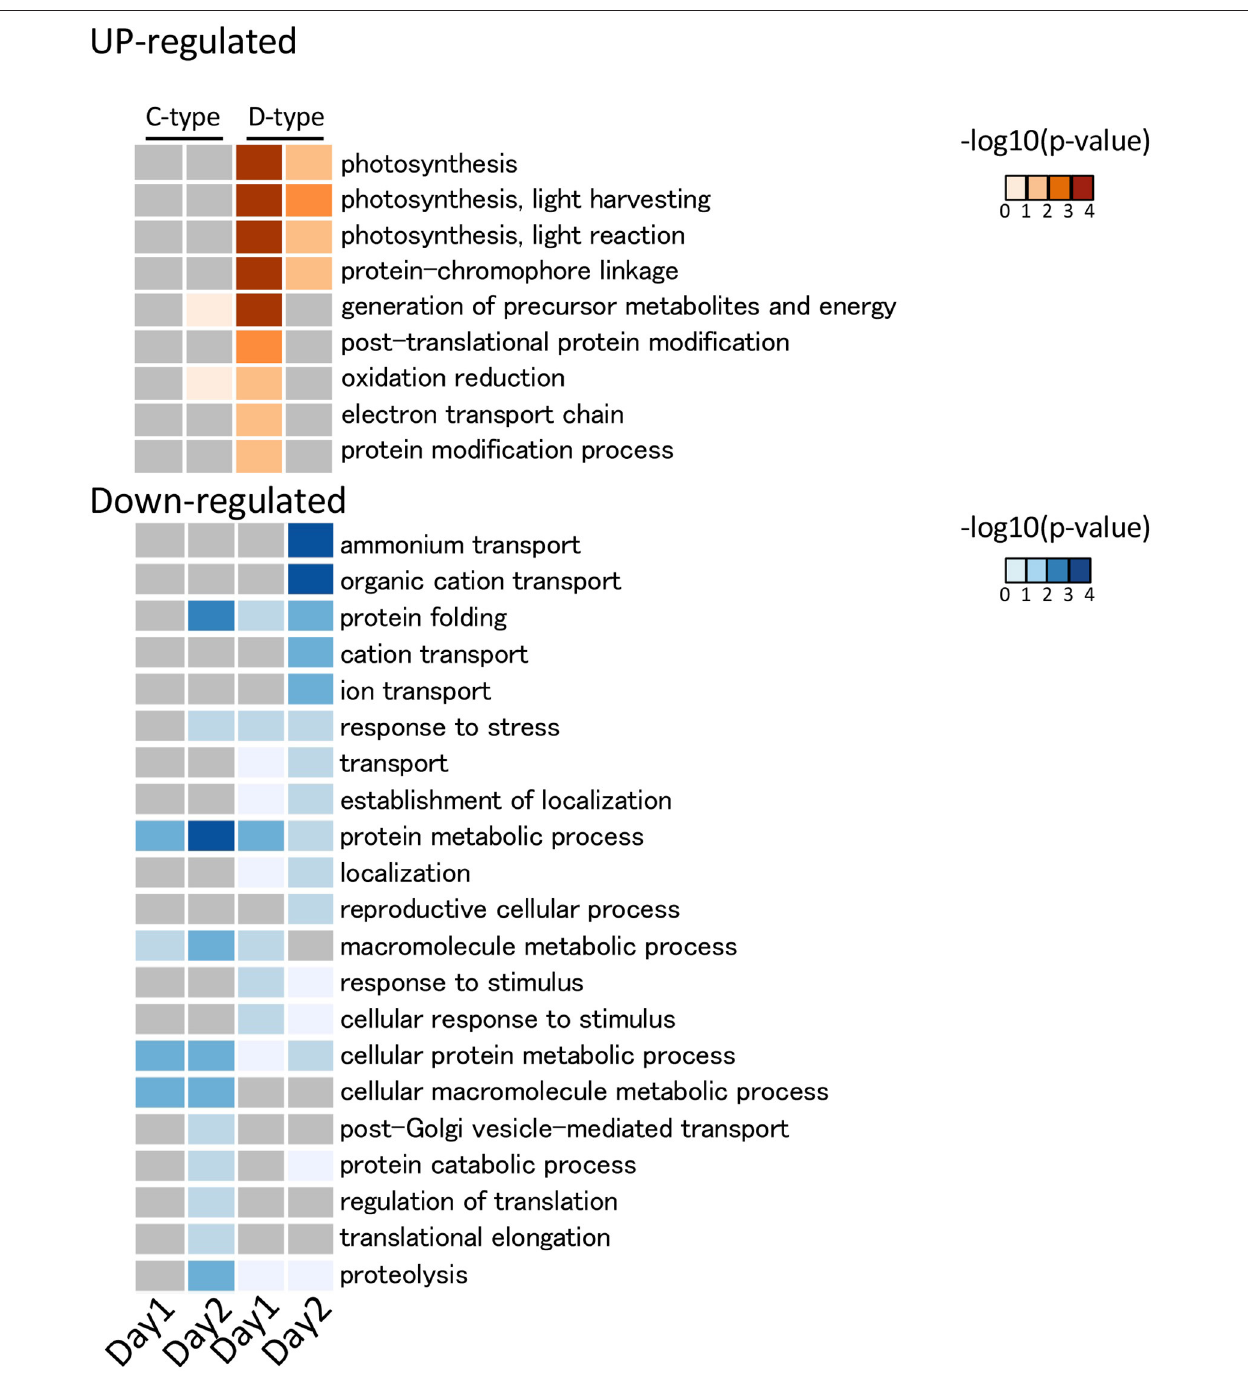
FIGURE 5 | GO functional analysis of Symbiodiniaceae DEGs detected using DAVID. The detected significantly ( p < 0.05) enriched GO terms in biological process are shown. The legend shows the color scaling with negative log10 p -value. In the C-type ( Cladocopium ), no significantly enriched GO term was detected in the upregulated DEG, while in D-type ( Durusdinium ), some photosynthesis-related GO terms were detected as upregulated DEGs. Among the downregulated DEGs, a GO term related to protein folding was enriched in both